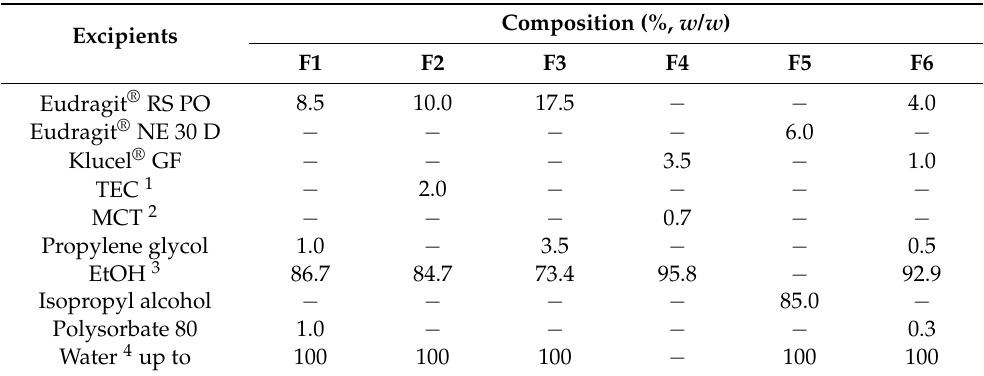
Composition (%, w/w